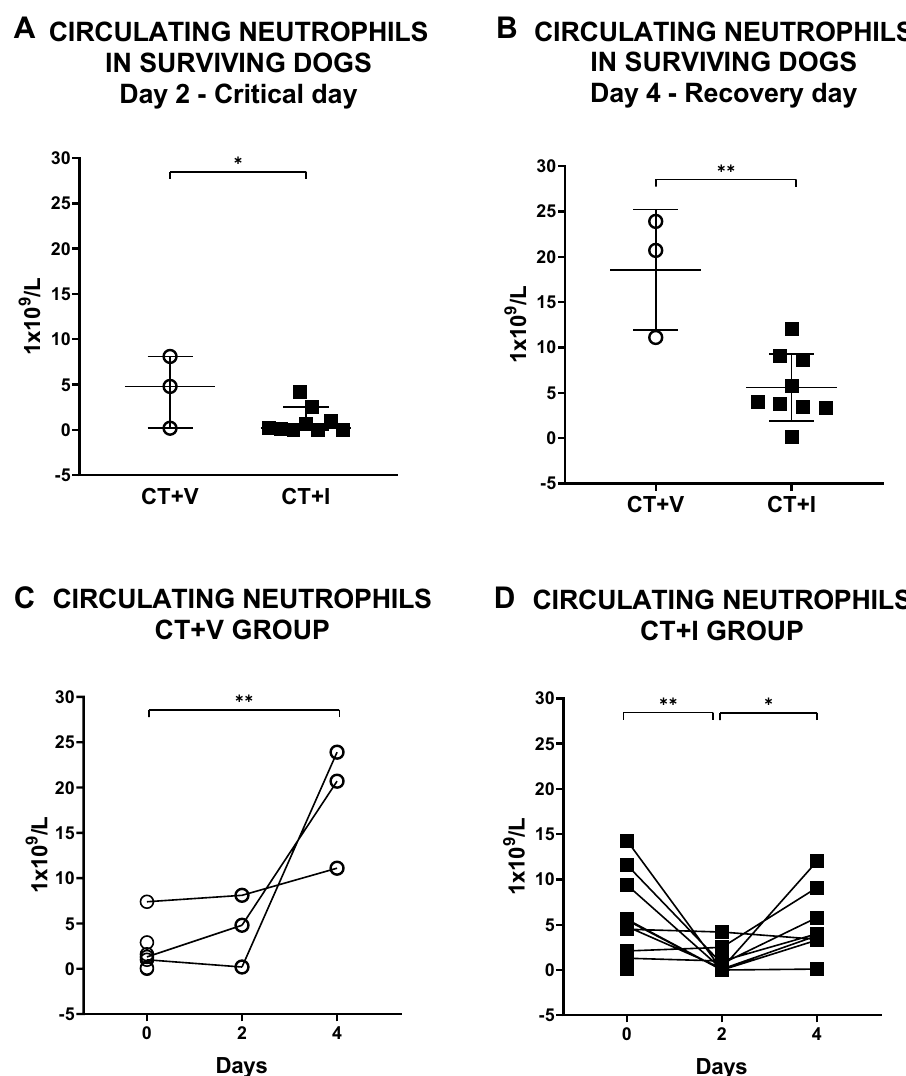
Figure 3. Effect of the immunomodulator over circulating neutrophil concentration of puppies affected by CPE. ( A ) Circulating neutrophils in surviving dogs (day 2-critical day) and ( B ) circulating neutrophils in surviving dogs (day 4-recovery day), statistical differences on days 2 and 4 are due to lower neutrophil concentrations in CT + I than in CT + V. Mann–Whitney test was done. Each dot represents a puppy. Median ± 5–95% confidence interval. ( C ) Neutrophil concentrations on day 0, critical day (2) and recovery day (4) in the CT + V group. Neutrophil concentrations on day 4 are responsible for statistical differences. ( D ) Circulating neutrophils on day 0, critical day (2) and recovery day (4), reduction in neutrophils on day two results in statistical differences in CT + I. Each dot represents a puppy. Kruskal–Wallis test and Dunn’s post-hoc test were carried out. *P ≤ 0.05, **P ≤ 0.01. CT conventional treatment, I immunomodulatory, V